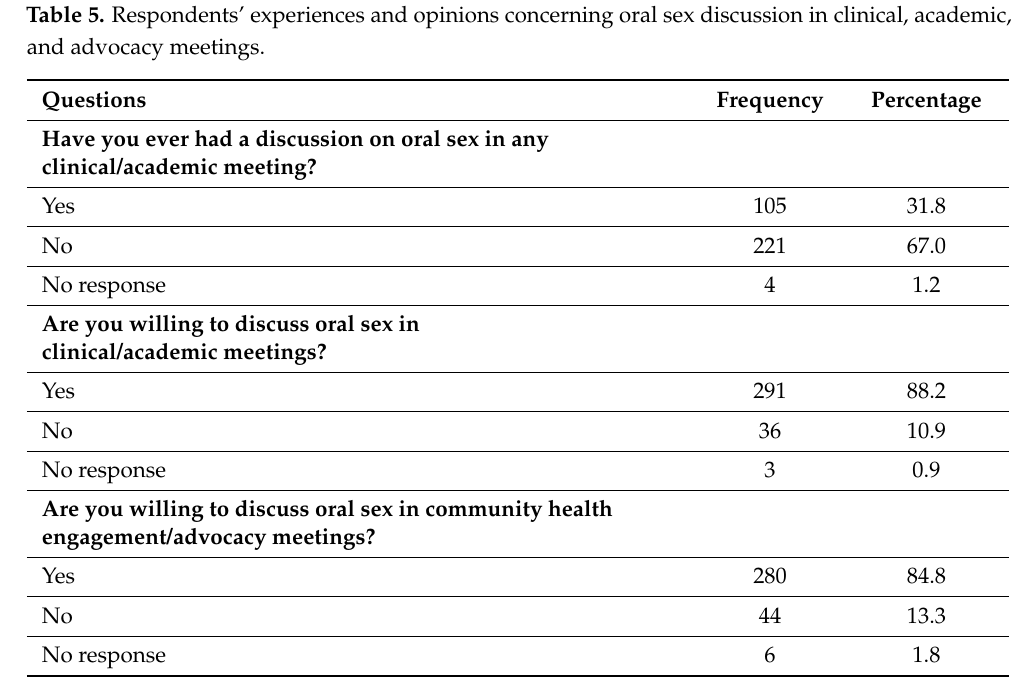
Figure 3. Preferred oral sex protection measures for patient use.